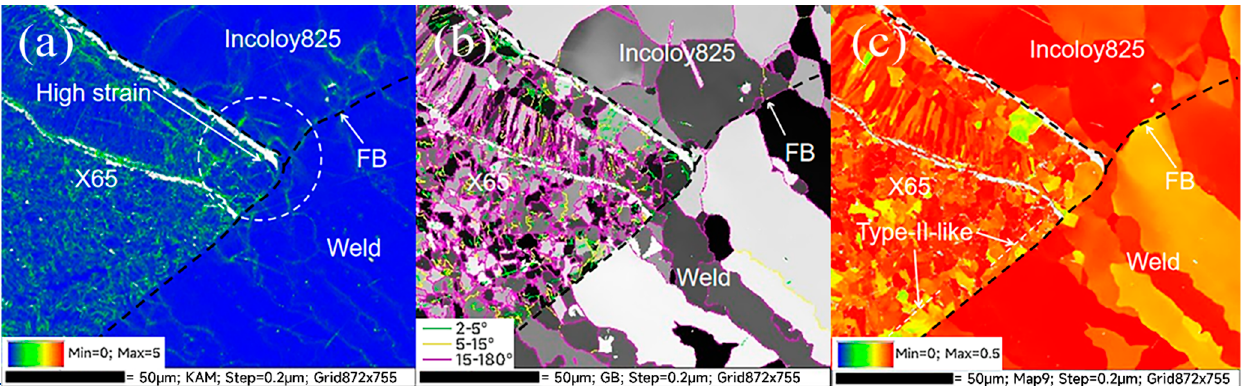
Figure 11. EBSD results at the intersection of the three zones: ( a ) KAM diagram; ( b ) grain boundary angle distribution; ( c ) Schmid factor diagram.